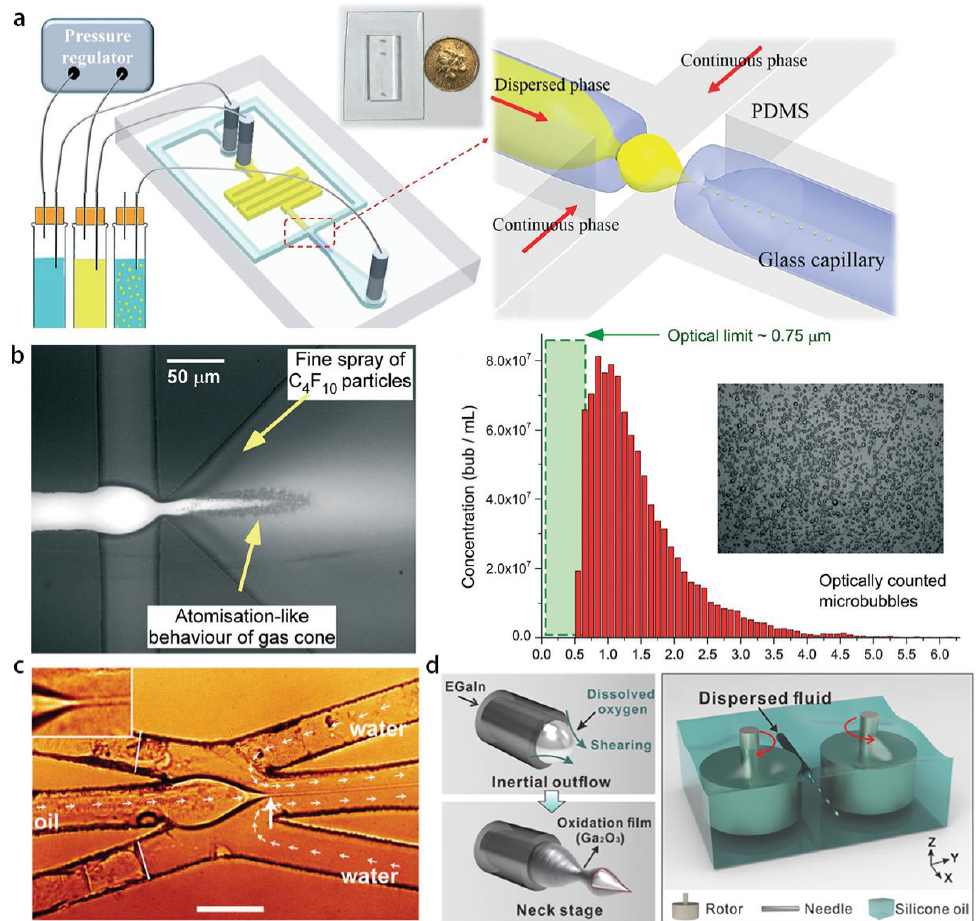
Figure 3. Recently developed microfluidic strategy with high emulsifying performance for tiny droplets. ( a ) Flame-shaped capillary hybrid with PDMS channel for realizing 3D flow focusing, pro- ducing submicron PFC droplets. Reproduced from [42], copyright 2017, Royal Society of Chemistry. ( b ) Atomization of lipid-stabilized bubbles in a PDMS channel with 3D expansion geometry, repro- duced from [43], copyright 2016, Royal Society of Chemistry. ( c ) Continuous phase back-flow induces tipstreaming with very thin jet without transition to the dripping mode, by avoiding the focusing effect, reproduced from [45], copyright 2018, Royal Society of Chemistry. ( d ) Rotary-flow-shearing method providing strong shear and elongational stress to the disperse fluid, reproduced from [46], copyright 2021, American Chemical